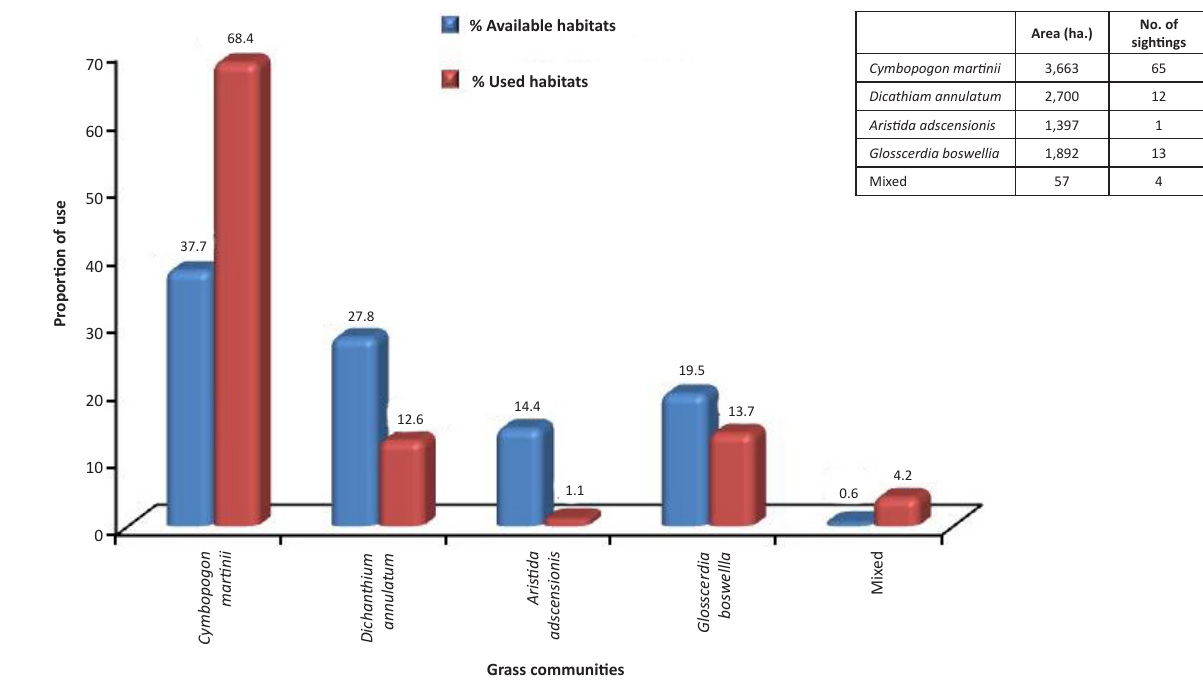
presence of sparse vegetation, short grasses and open land, the visibility is high in the grassland habitat which favors the survival of the heavy-bodied bustard. The invasion by Prosopis juliflora is prominent in some of the areas particularly on the periphery of grasslands. The majority of the grass species remains green (Image 3) during the rainy days and start becoming paler yellow as winter approaches (Image 1) and become completely dry during summer (Image 2). However, as the area is located on the coast of Arabian Sea, the sea breeze carrying moisture help the growth of summer shoots of the food items for the herbivore Spiny-tailed Lizard ( Saara hardwiicki ) in the region (Dutta & Jhala 2007).